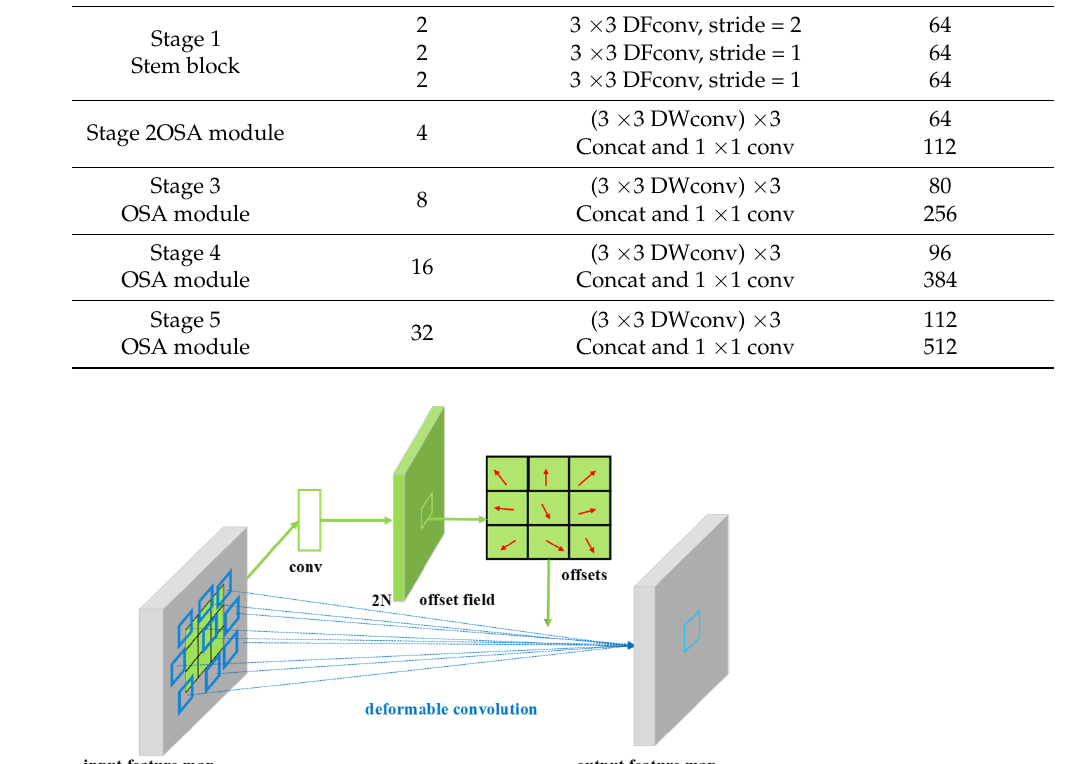
Figure 3. Deformable convolution. The number of generated channel dimensions is 2N, correspond- ing to both the original output features and the offset features.